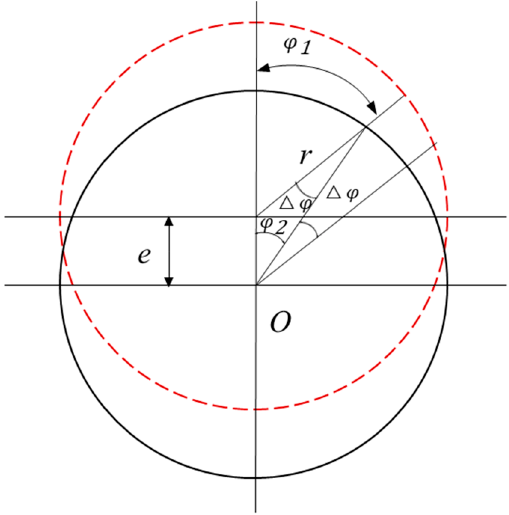
Figure 6. Eccentricity error.